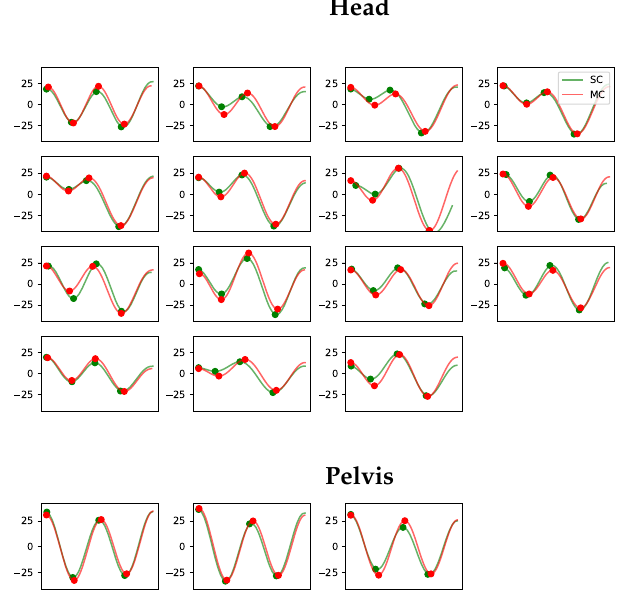
Figure A23. Vertical displacement signals per stride for the head and pelvis for horse 24. Each subplot contains the matched stride segments for the single-camera markerless system (SC) in green and the multi-camera marker-based system (MC) in red. The y-axis shows the vertical displacement in millimeters. The four dots on each curve indicate the positions of the two peaks and two valleys extracted using the approach in Section 2.6.2.